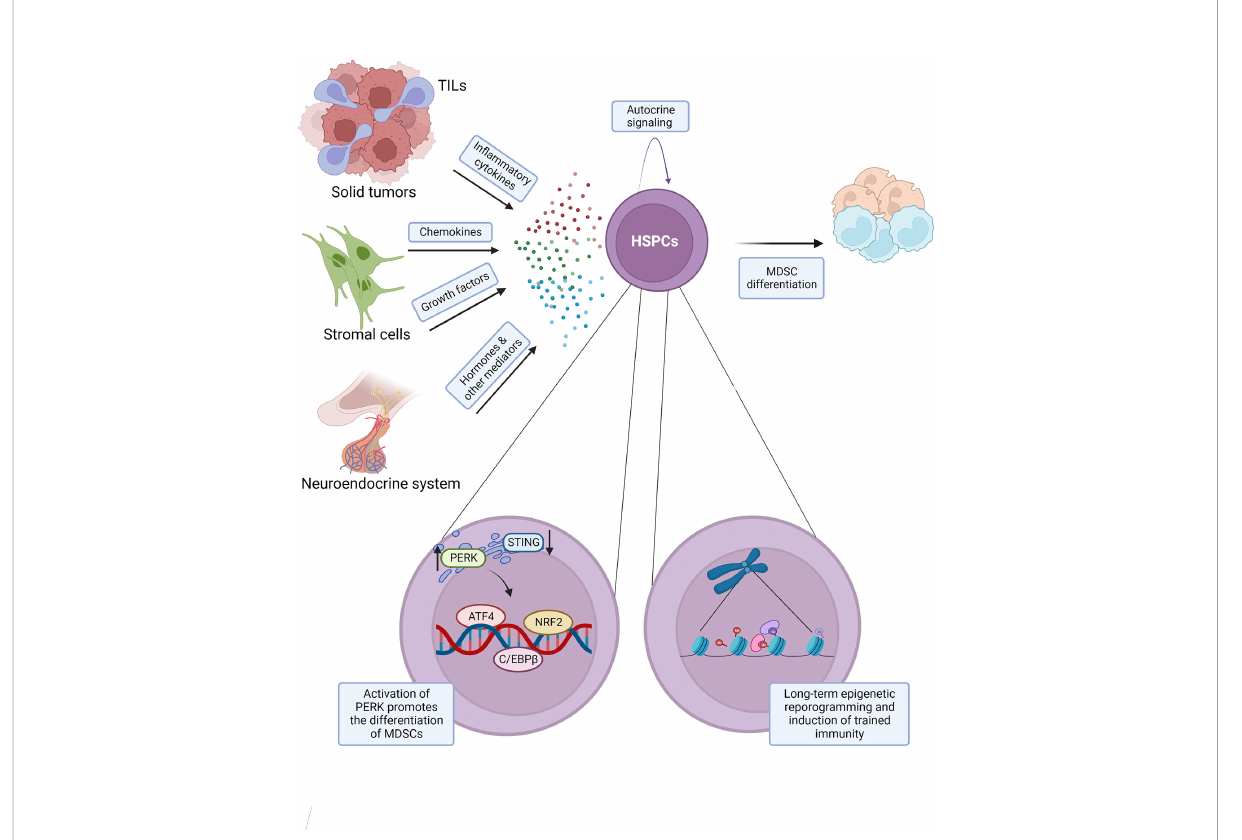
FIGURE 2 Molecular regulation of cancer associated myelopoiesis. Secreted mediators promoting cancer associated myelopoiesis include: in fl ammatory cytokines such as IL-6, IL-1, and TNF a , chemokines such as CCL2, CCL3, and CCL4, growth factors G-CSF, GM-CSF, and others, and hormones and other mediators, such as estrogen, a -MSH, osteopontin, and angiotensin II. Such mediators may exert their effects on the hematopoietic system via both direct and indirect mechanisms. Cancer induced myelopoiesis and the production of tumor associated neutrophils and monocytes with immunosuppressive properties are promoted by the activation of unfolded protein response (UPR), including kinase PERK and transcription factors ATF4 and NRF2 in hematopoietic stem and progenitor cells (HSPCs). Cancer disease may also result in a long-term epigenetic reprogramming of HSPCs and the induction of aberrant trained immunity. This model integrates fi ndings from multiple cancer types and experimental systems, and the indicated mechanisms may not be conserved across all